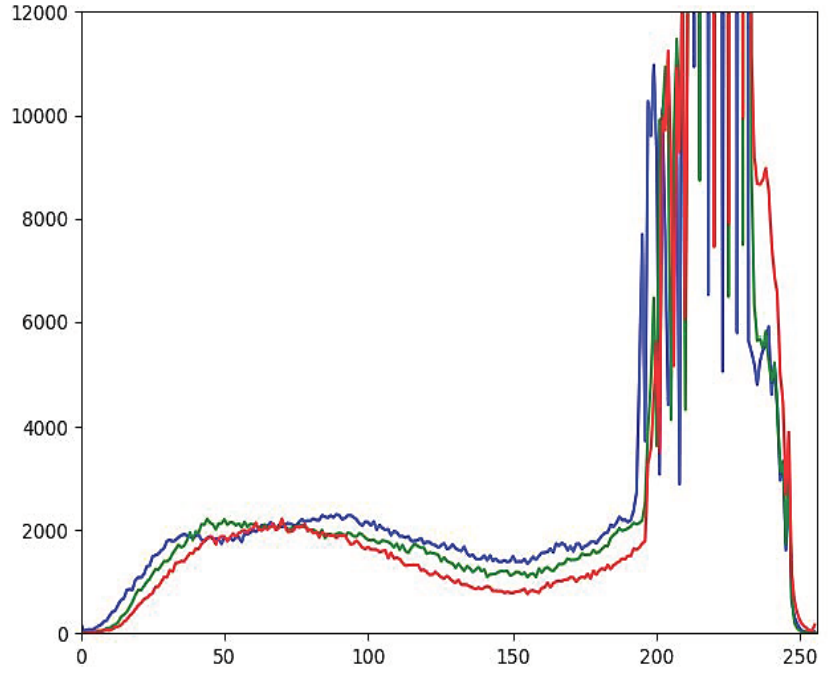
Figure 31. Histogram of the RGB graph for the image (see Figure 30).